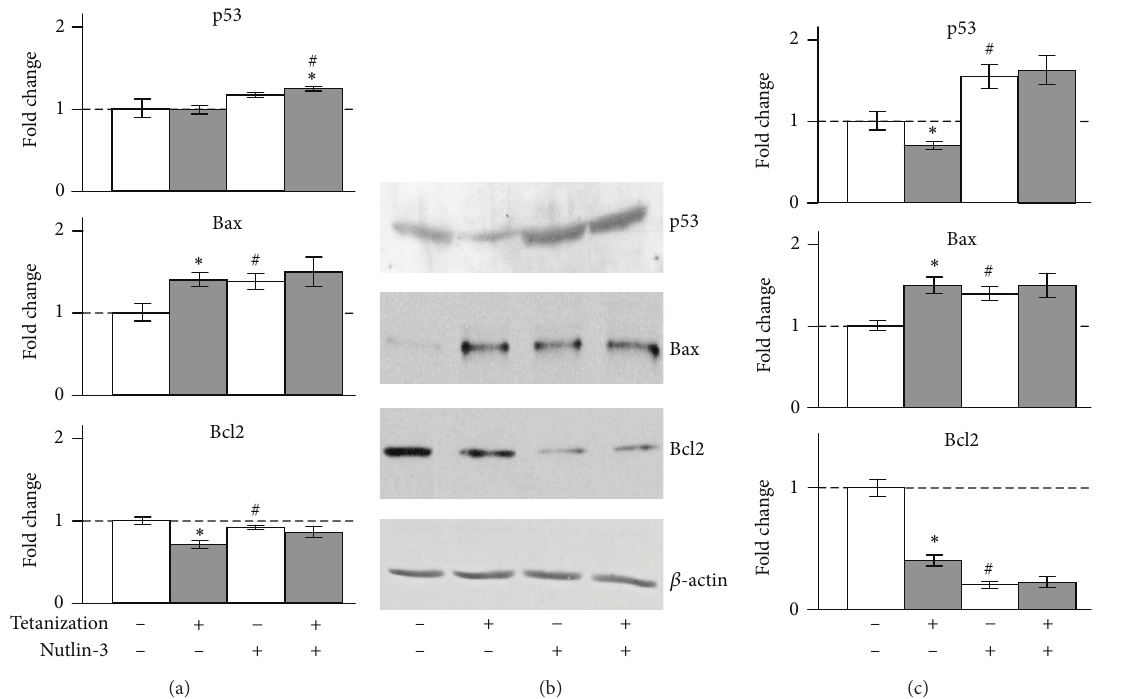
Figure 2: Effect of tetanization on p53, Bax, and Bcl2 in the rat hippocampal CA1 area. (a) Total RNAs were prepared and subjected to real- time PCR for the measurement of mRNAs. The mean of Ct values of five housekeeping genes was used as internal control for normalization as described in Section 2. (b) Representative Western blots. Whole-cell extracts were prepared from the rat hippocampal CA1 area and subjected to Western blot analysis as described in Section 2. (c) Relative intensity. The protein bands were analyzed by the computerized densitometric program “Total Lab.” The intensities of the signals were determined from the areas under the curves for each peak and data were graphed. 𝛽 -actin was used as internal control for normalization. The fold changes were expressed by taking the average value of the group tetanization (−) /nutlin-3 (−) as one. ∗ 𝑃 < 0.05 against corresponding tetanization (−) samples (paired 𝑡 -test), # 𝑃 < 0.05 against the group tetanization (−) /nutlin-3 (−) ( 𝑡 -test), 𝑛 = 4